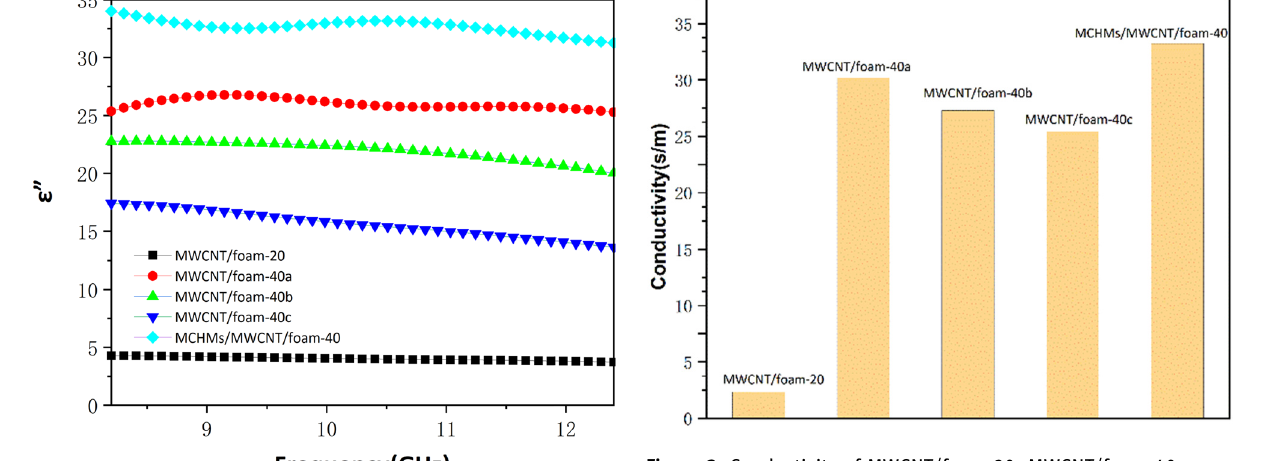
Figure 3: Conductivity of MWCNT/foam - 20, MWCNT/foam - 40a, MWCNT/foam - 40b, MWCNT/foam - 40c, and MCHMs/MWCNT/foam -